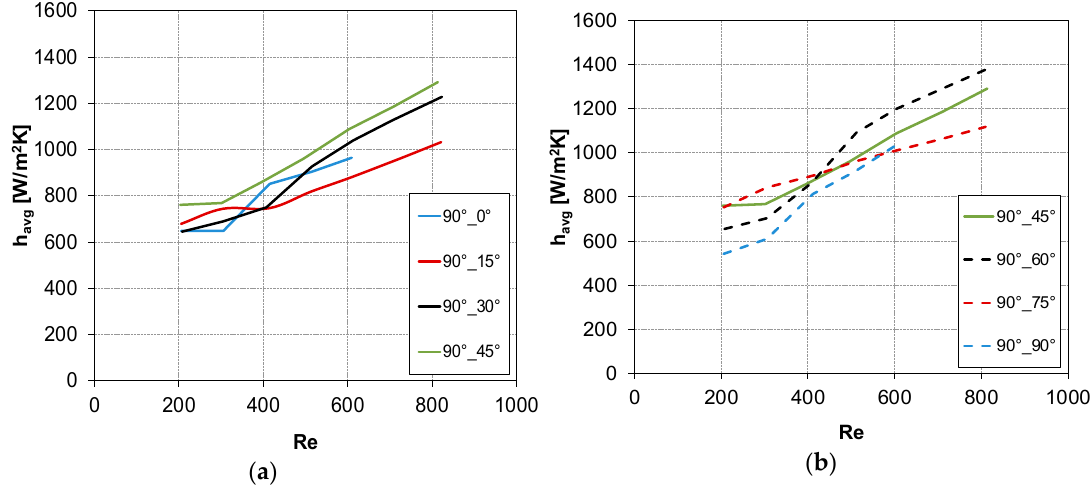
◦ : ( a ) α ≤ 45 ◦ and ( b ) α ≥ 45 ◦